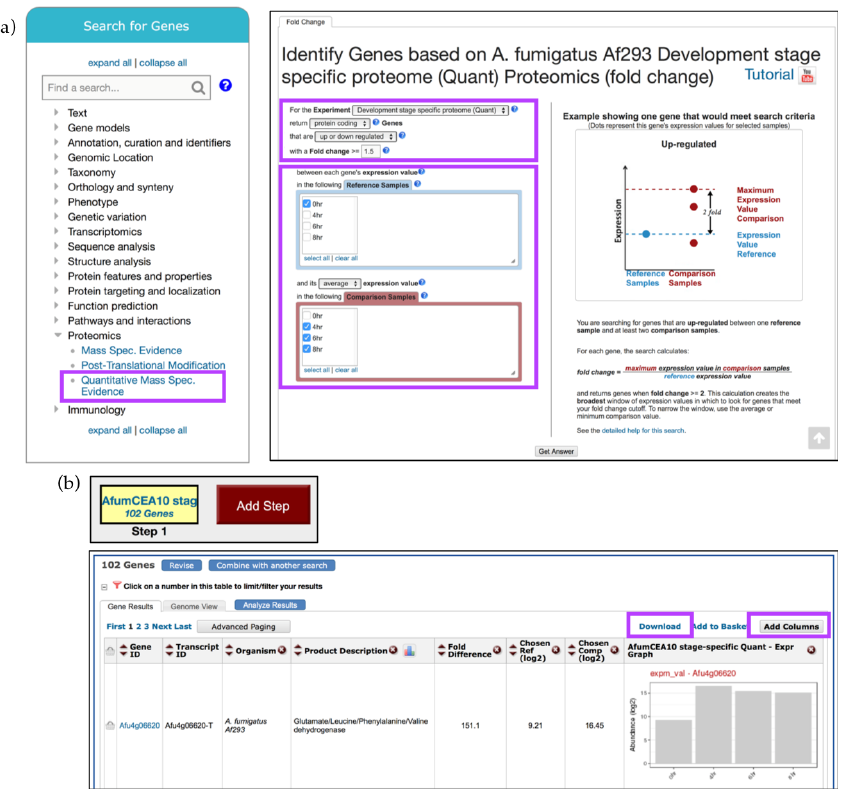
Figure 5. Quantitative Mass Spec. search examining up-regulated genes in A. fumigatus Af293 during conidial growth. ( a ) Select the Quantitative Mass Spec. Evidence menu (highlighted in purple) to access Suh et al. dataset and select Reference and Comparison Samples as shown to identify genes that are up-regulated throughout conidial development. The selection parameter areas are highlighted in purple; ( b ) Overview of the search strategy. Explore results, Add Columns , or Download results (highlighted in purple). Strategy in FungiDB: http://fungidb.org/fungidb/im.do?s=96851d3ef002899a.